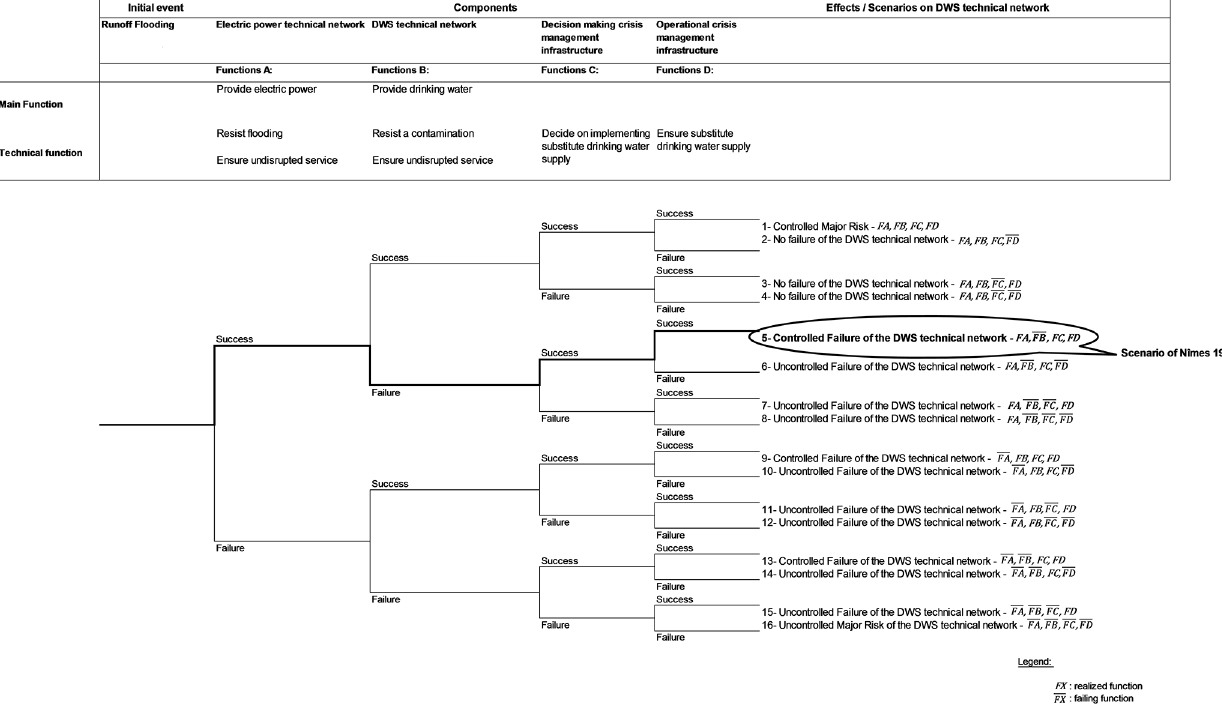
Figure 5. Event tree representing the drinking water supply technical network failure during the 1988 flooding in Nîmes.